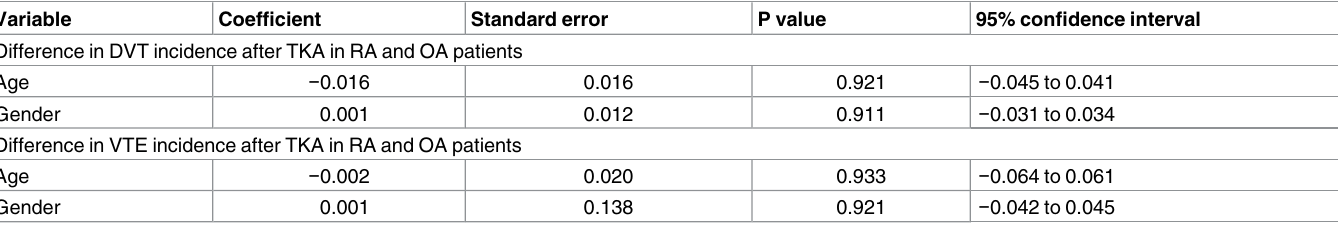
Table 2. Meta-regression analysis comparing associations of age and gender with rates of deep vein thrombosis (DVT) and venous thromboem- bolism (VTE) after total knee arthroplasty in patients with rheumatoid arthritis and osteoarthritis. Variable Coefficient Standard error Difference in DVT incidence after TKA in RA and OA